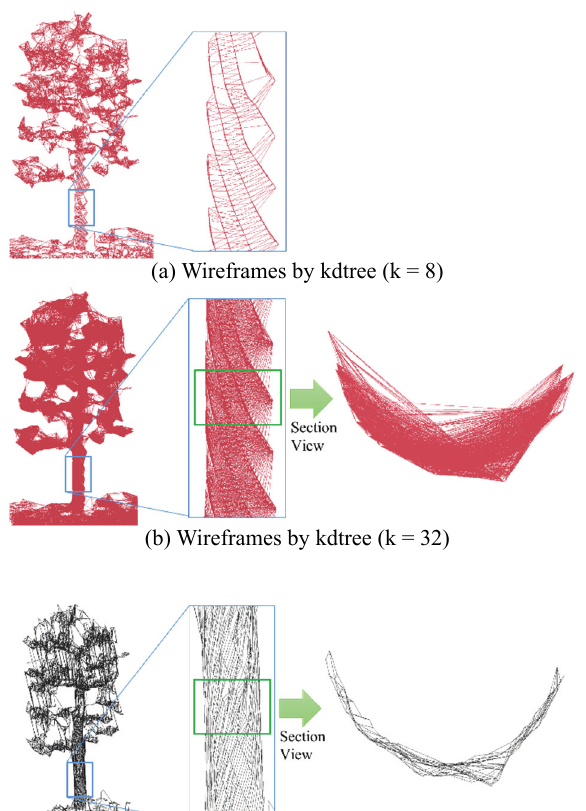
Figure 5 . Distance between points of MMS point clouds